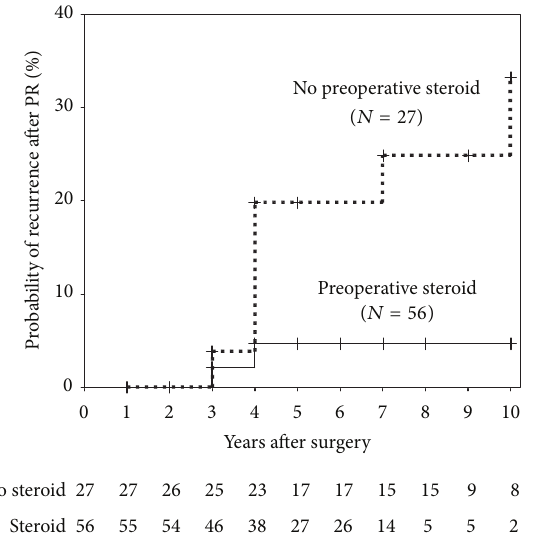
Figure 3: Kaplan-Meier curves for the defined recurrence after the modified PR status: there were 83 MG patients that achieved the modified PR status during followup (preoperative steroid, 56, no preoperative steroid, 27) without censure. These MG patients in the no preoperative steroid treatment group (broken line) exhibited a significantly higher rate of the defined recurrence than those in the preoperative steroid treatment group (solid line) (log-rank test, 𝑃 = 0.03 ). Vertical bars indicate censured data.